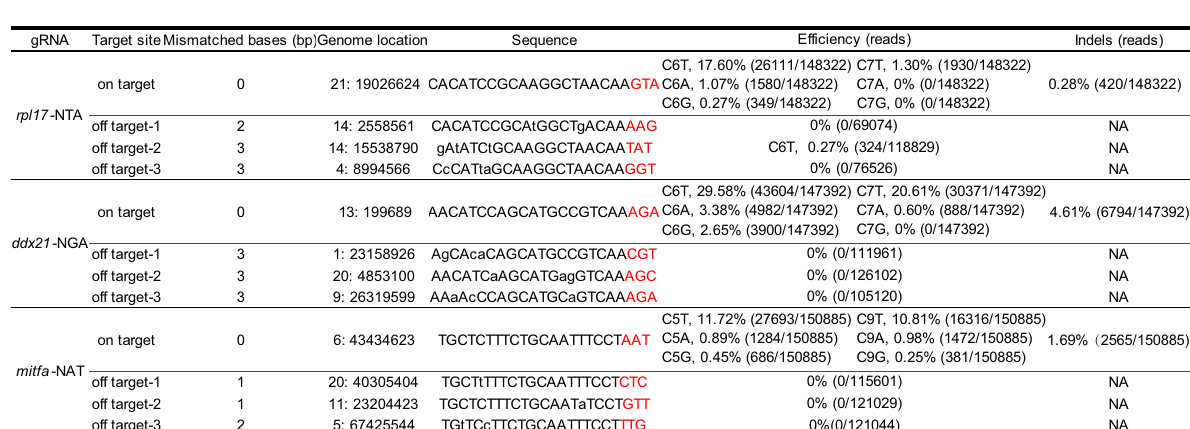
gRNA Target siteMismatched bases (bp)Genome location